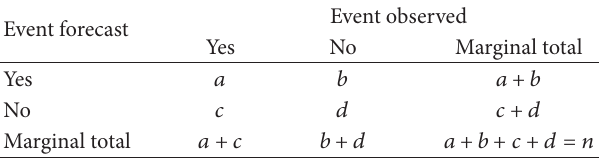
Table 1: Heidke Skill Score input